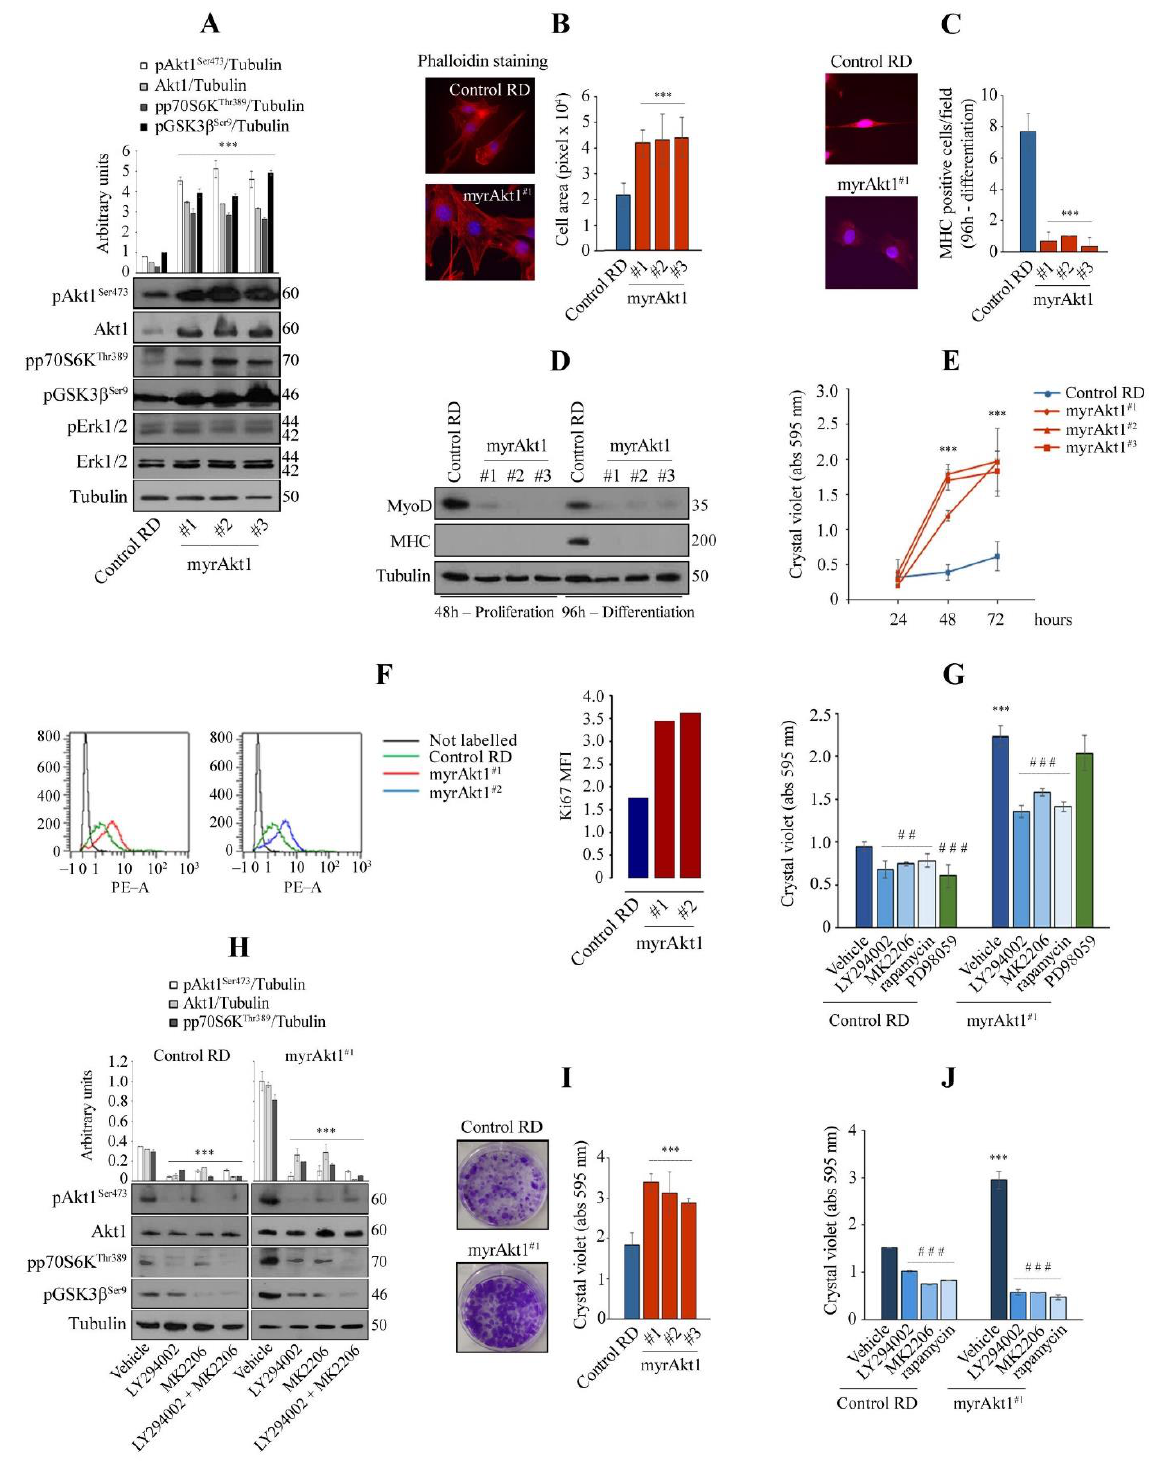
Figure 1. Analysis of cell differentiation and growth in the RD line expressing a myrAkt1 form. ( A ) Control and myrAkt1 cells (1.5 × 10 5 ), seeded into 60 mm dishes, were left to proliferate for 48 h before collecting protein samples. Activation of Akt1 signaling was determined by IB with the indicated antibodies ( n = 2). Data are mean ± SEM, *** p -value < 0.0001; one-way Anova test. ( B ) Under the same conditions seen above, cells were seeded on coverslips and stained with fluorescent red phalloidin. Representative images were taken using a fluorescent microscope at 63× magnification ( n = 2). Quantification of the cell area was calculated by using ImagePro Plus software. Data are mean ± SEM , *** p -value < 0.0001; one-way Anova test. ( C ) Control and myrAkt1 cells (2 × 10 5 ),